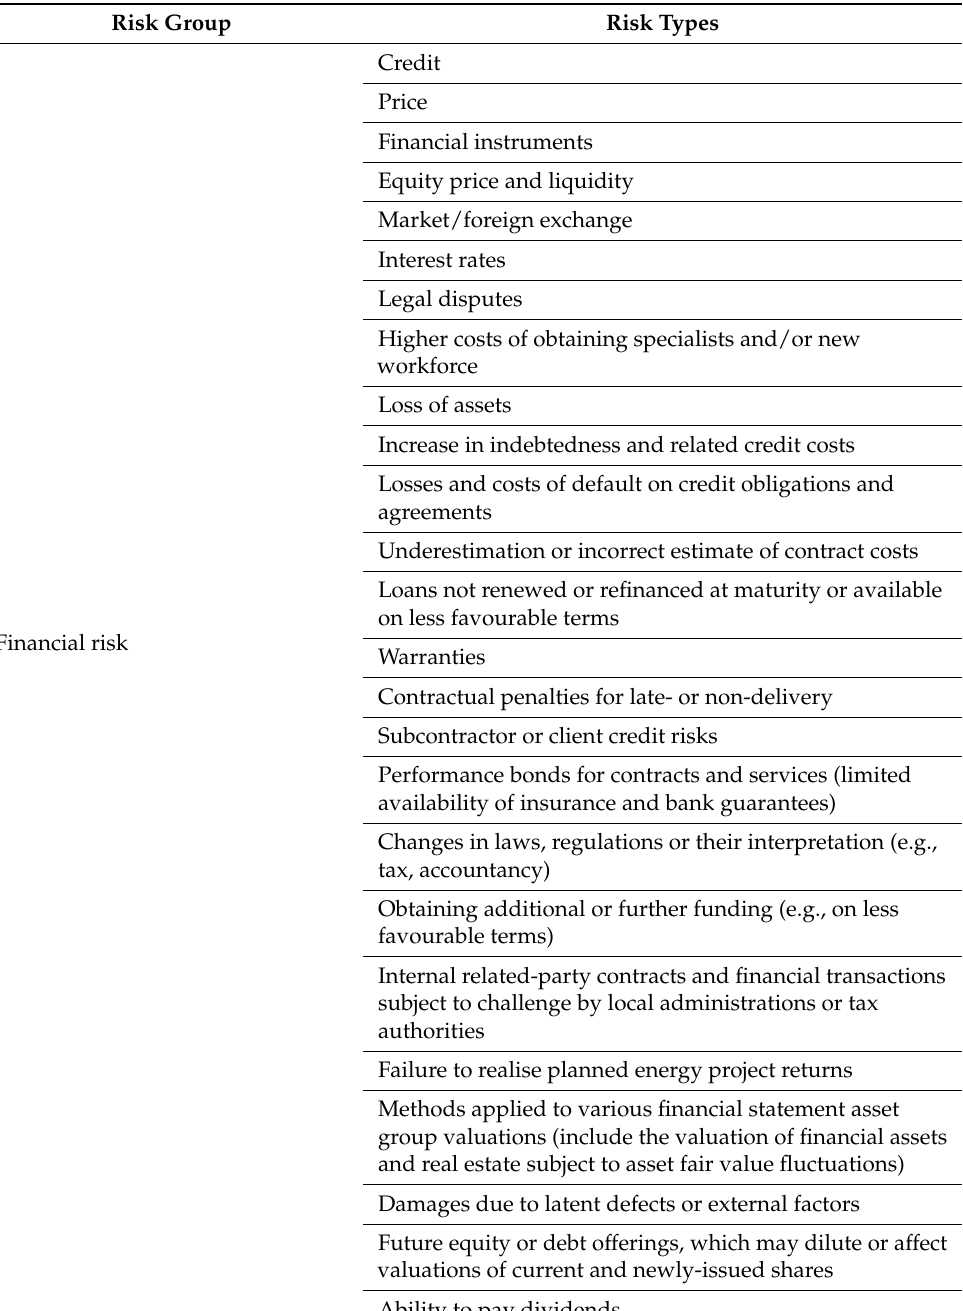
Table 7. Risk classification in energy company annual non-financial